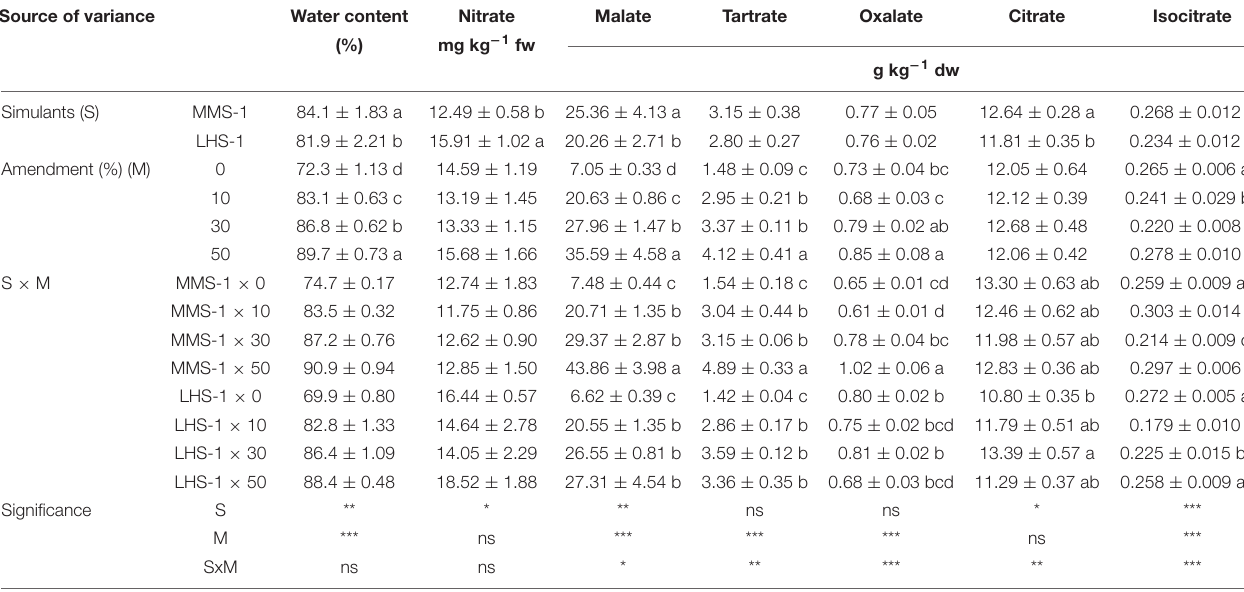
TABLE 1 | Water, nitrate, and organic acid contents of grown lettuce in different mixtures of MMS-1 or LHS-1 simulants and manure (simulant/manure rates: 100:0, 90:10, 70:30, 50:50; w/w). Source of